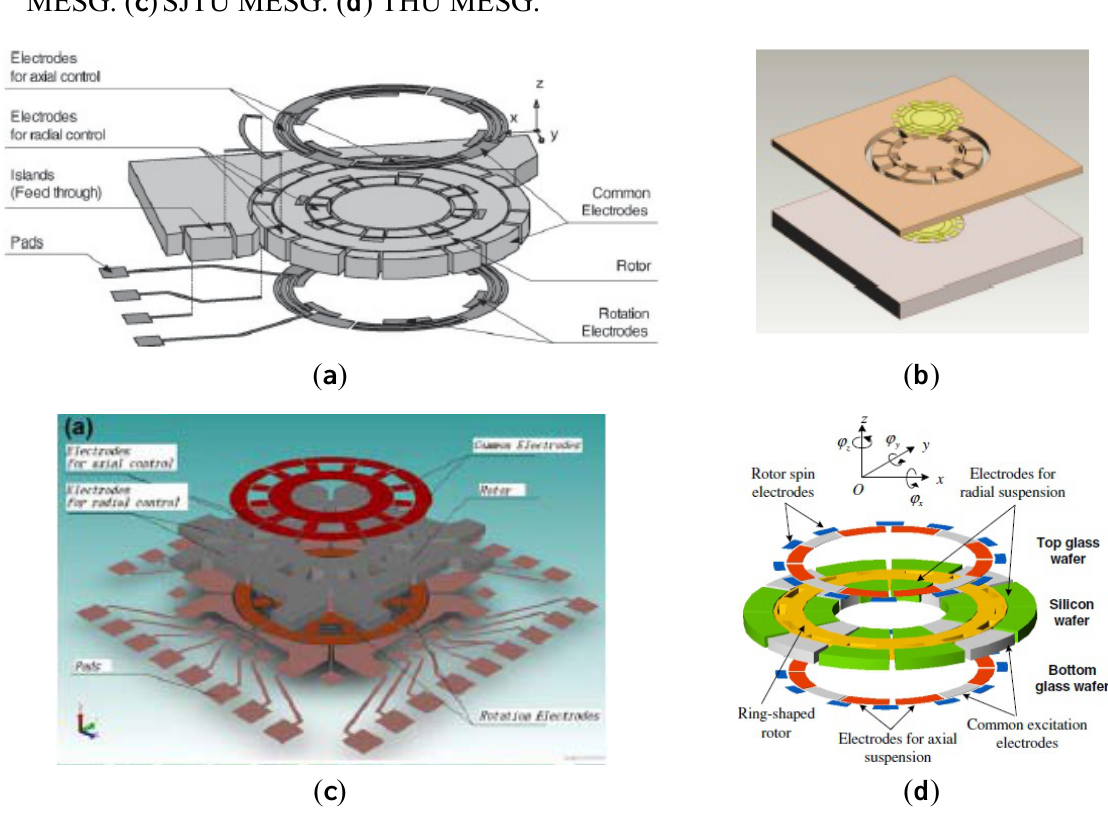
Figure 14. Various MESGs. ( a ) Tohoku University MESG. ( b ) University of Southampton MESG. ( c ) SJTU MESG. ( d ) THU